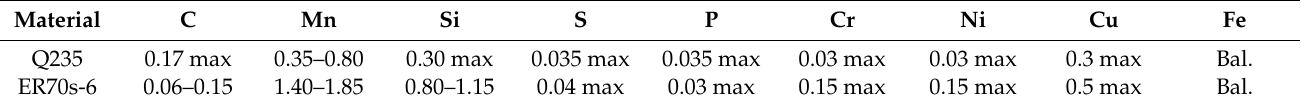
Table 1. Nominal chemical composition of Q235 steel and ER70s-6